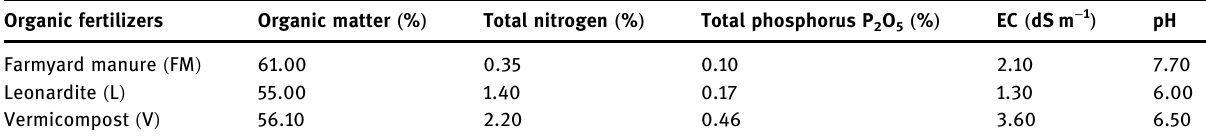
Table 1: Some chemical properties of organic fertilizer used in the experiment Organic fertilizers Organic matter ( % ) Farmyard manure ( FM